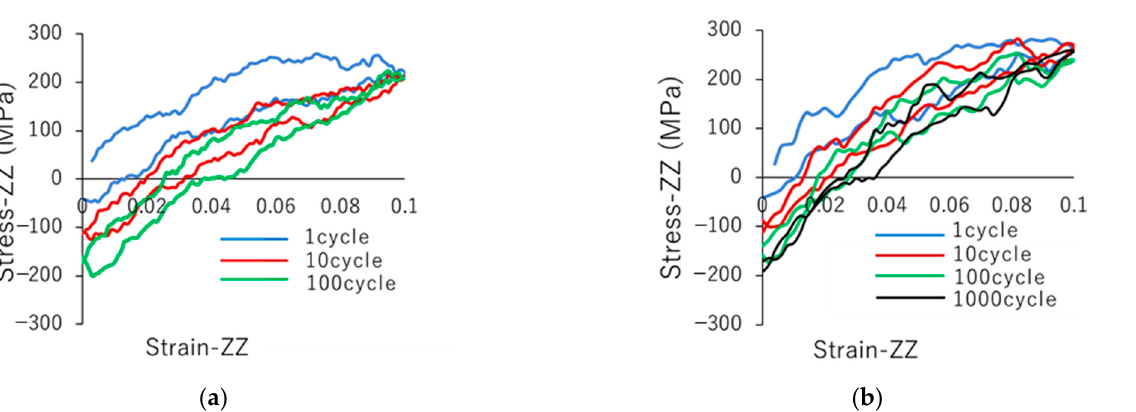
Figure 5. Stress–strain curves for strain rates of ( a ) 5.0 × 10 8 /s and ( b ) 5.0 × 10 9 /s.